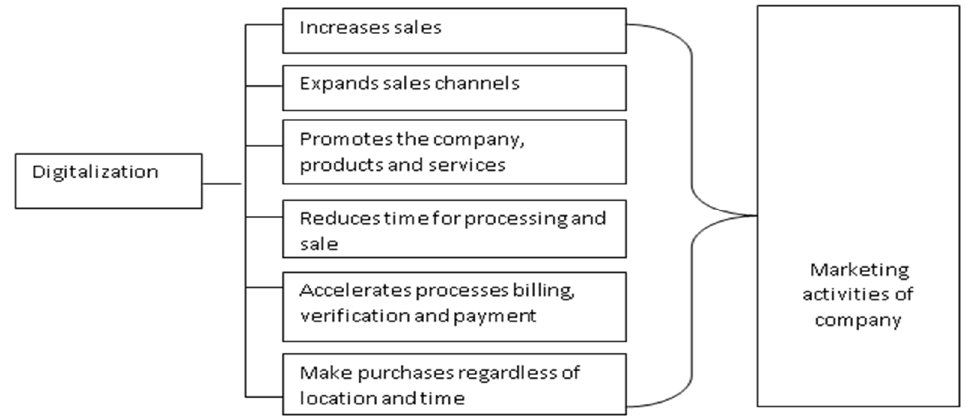
Figure 1. Key factors of the impact of digitalization on marketing activities.